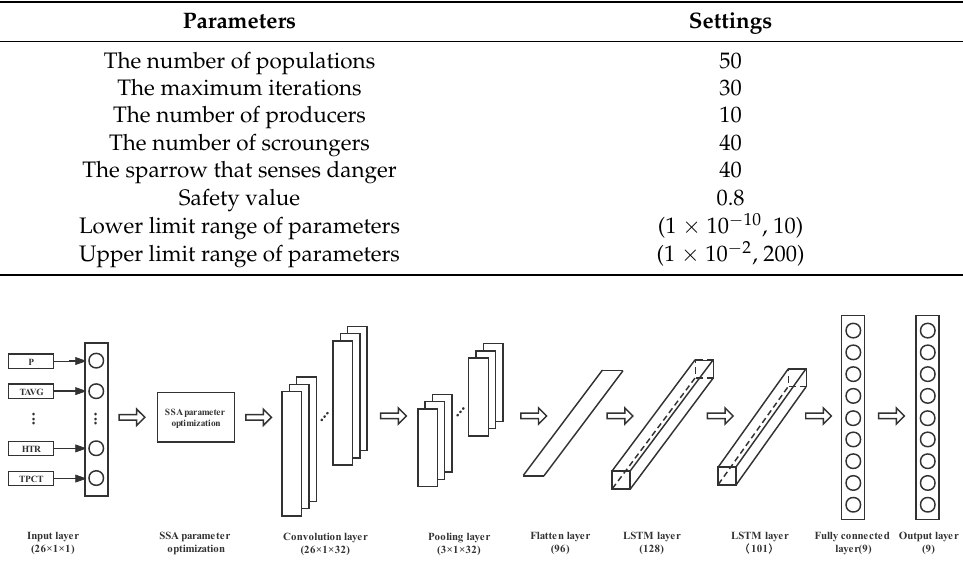
Table 4. Sparrow search algorithm parameters.